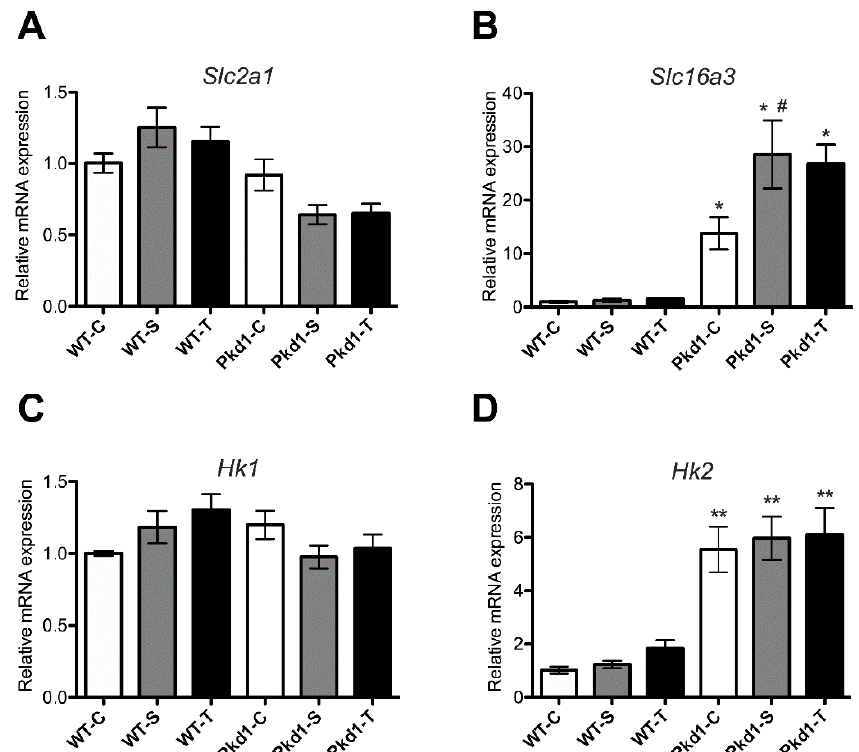
Figure 8. Effect of trehalose on the expression of glycolysis-related genes in the kidneys of the Pkd1 miRNA transgenic mice. The relative renal mRNA amounts of ( A ) Slc2a1, ( B ) Slc16a3, ( C ) Hk1, and ( D ) Hk2 in the mice in the different experimental groups compared with wild-type mice are presented ( n = 3, 6, 9, 9, 8, and 7 per group, respectively). * p < 0.05, ** p < 0.01 compared with the wild-type control group. # p < 0.05 compared with the Pkd1 control group. WT, wild-type; PKD, polycystic kidney disease; C, control; S, sucrose; T, trehalose.